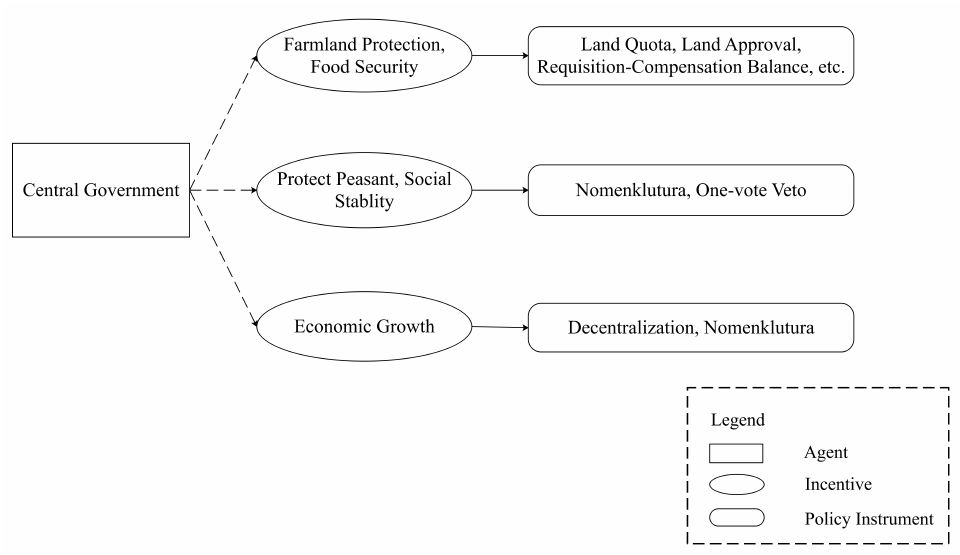
Figure 3. Incentives and policy instruments of central